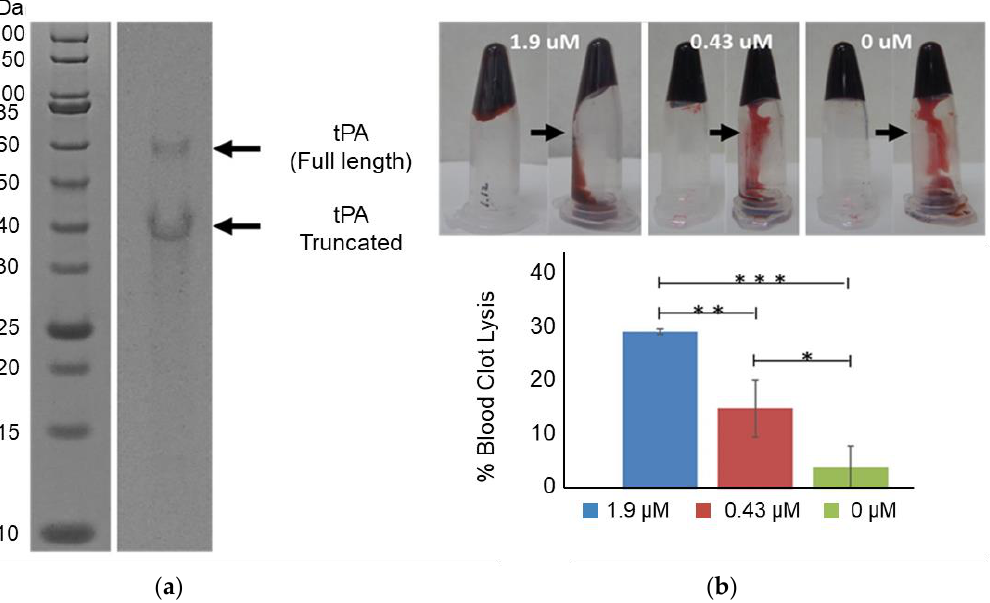
Figure 2. Purification and Activity of tPA. Nickel-affinity column-purified tPA was separated by SDS-PAGE and the gel was exposed to autoradiography film. Samples were also tested with a blood clot lysis assay: ( a ) Autoradiogram analysis showed both a full-length (63 kDa) and truncated tPA (about 40 kDa); ( b ) Analysis of blood clot lysis with CFPS expressed tPA. *** = p < 0.005, ** = p < 0.05, and * = p < 0.1. Error bars represent one standard deviation.